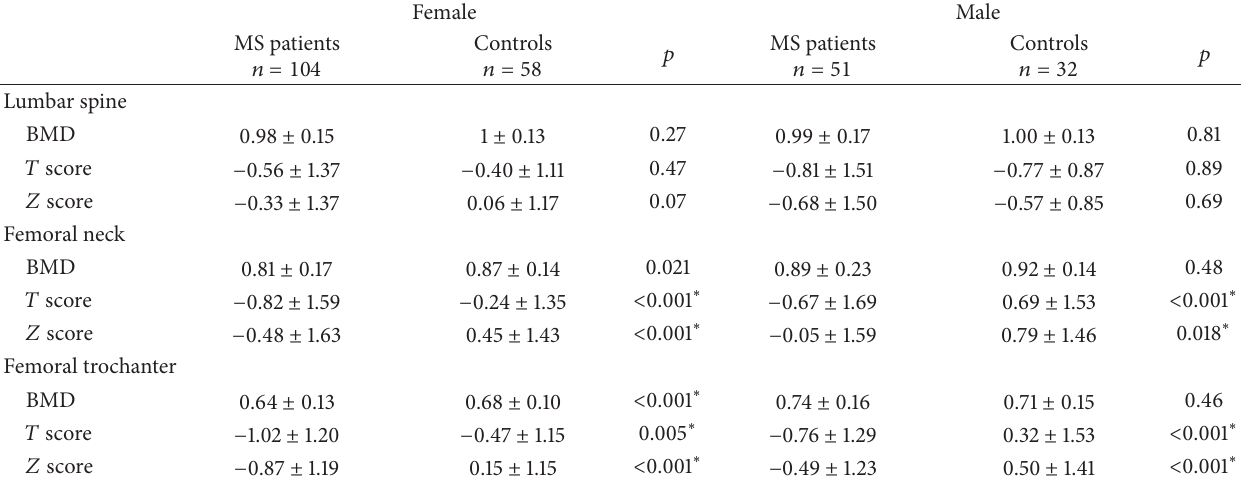
Table 2: Comparisons of bone mineral density measurements (mean ± SD) at lumbar and femoral sites between MS patients and controls.